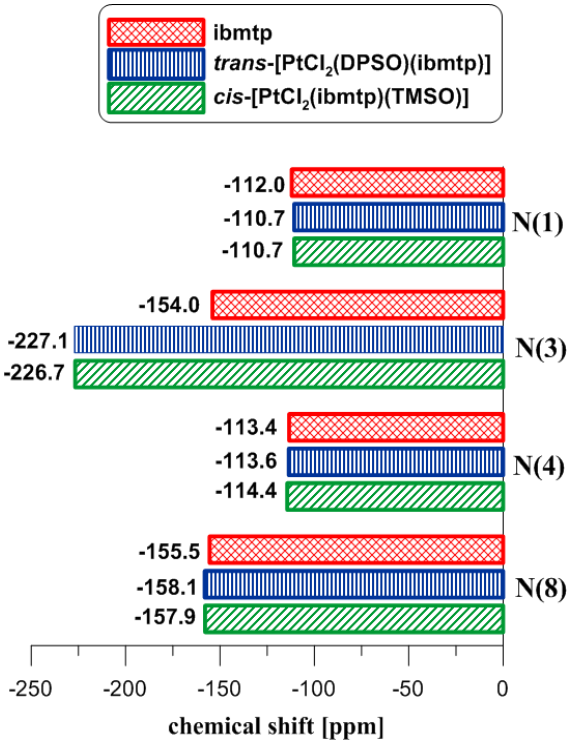
Figure 4. 15 N NMR chemical shifts of free ligand (ibmtp) and platinum(II) complexes